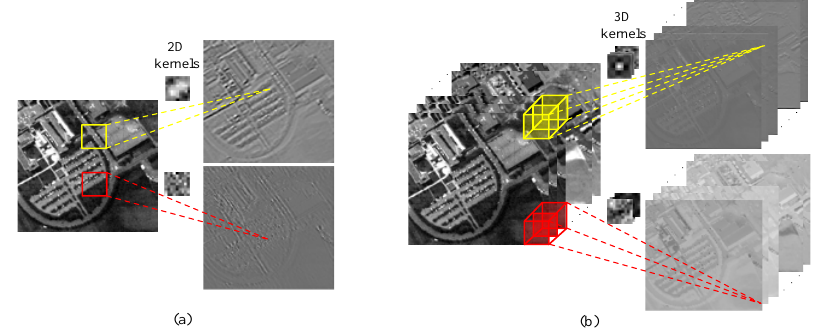
Figure 2. The illustration of ( a ) 2D and ( b ) 3D convolutional operations, feature maps and feature cubes are generated in each layer of 2D convolutional neural network (CNN) and 3D CNN respectively.